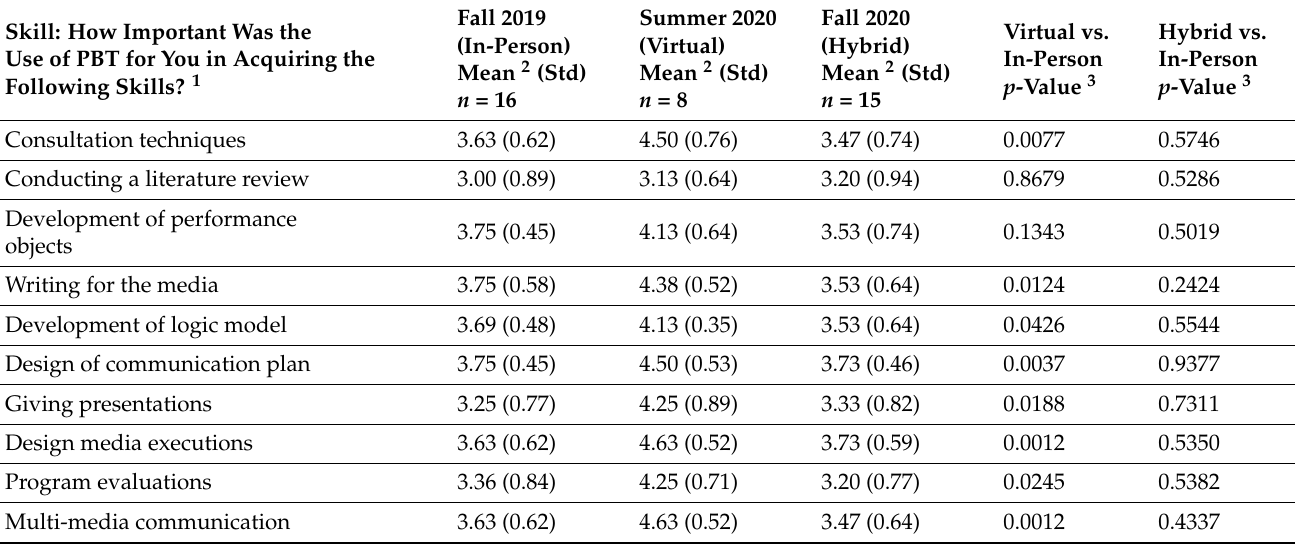
Table 2. Post-Course Student Skill Acquisition across Three Semesters of PBT Course: In-Person, Virtual, and Hybrid ( n =